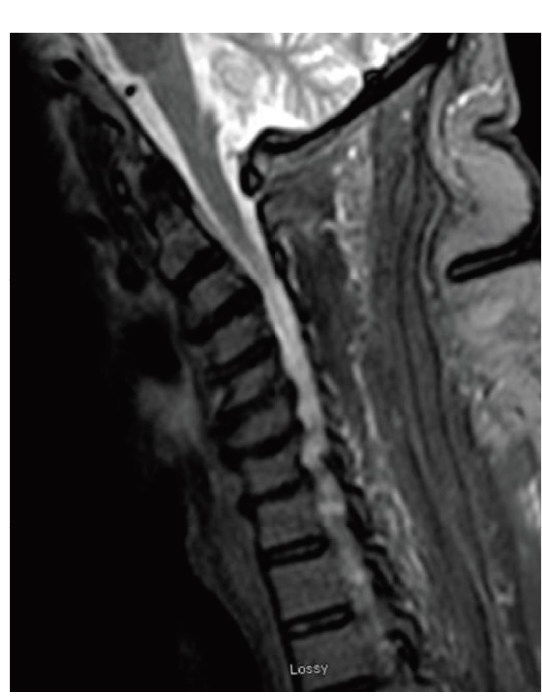
Figure 2: MRI cervical spine.